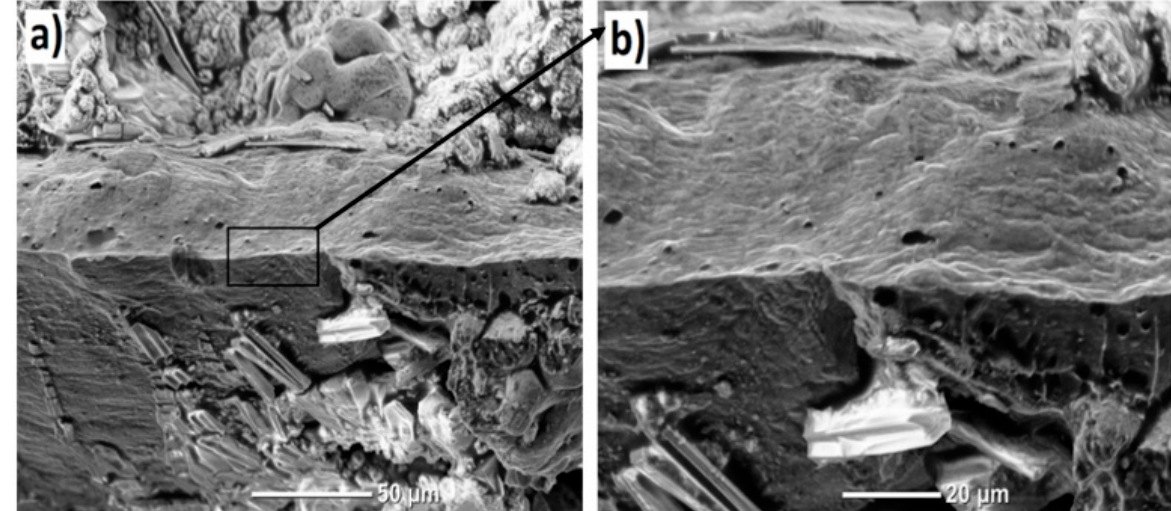
Figure 18. SEM analysis of CMFM part: ( a ) Fractured foil at 500×; ( b ) fractured foil at 1000×.